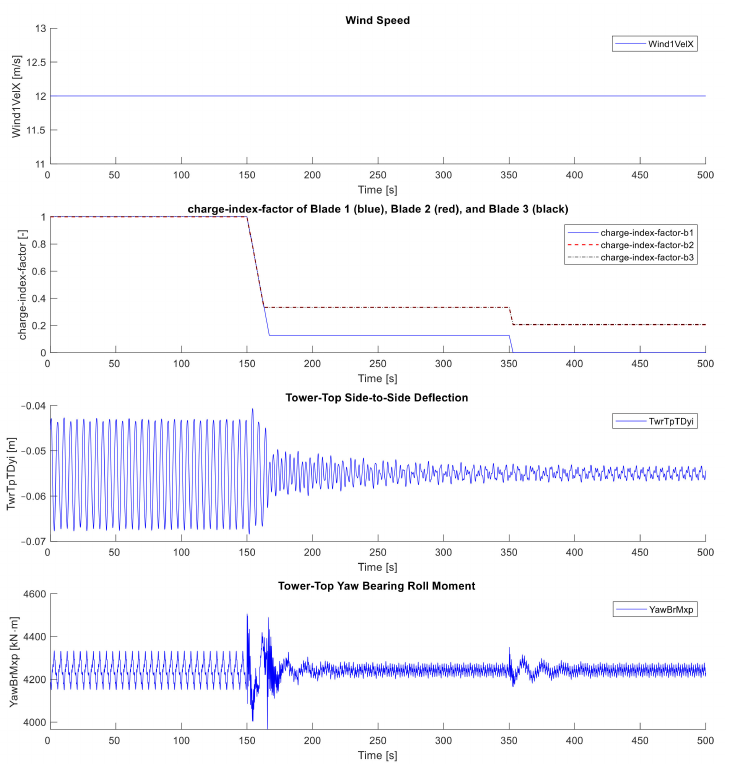
Figure 9. Impact of the flywheel system on a tower-top side-to-side deflection by imbalance in the rotor